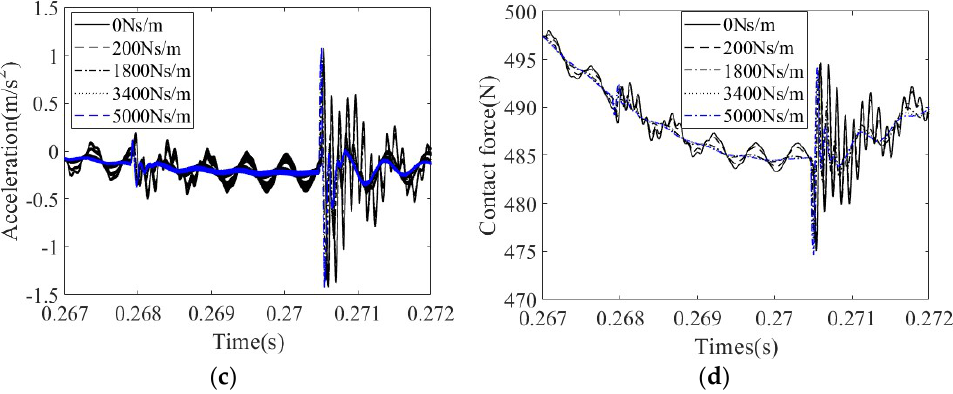
Figure 25. The vibration characteristics of the bearing under roller defect and viscous damping: ( a ) RMS; ( b ) amplitudes of f c , f b − f c , f b , f b + f c , 2 f b − f c , 2 f b , 2 f b + f c ; ( c ) housing acceleration signal from 0.267 s to 0.272 s; ( d ) contact force between outer ring and housing from 0.267 s to 0.272 s.